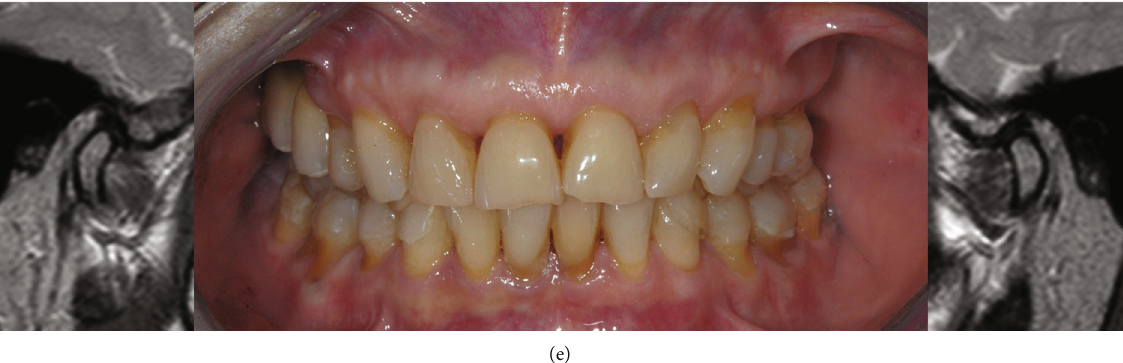
Figure 1: Clinical work fl ow for an occlusal vertical dimension increase in a patient showing worn dentition. ((a) and (b)) Pre-operative intra-oral occlusal photographs showing signs of cervical abrasion/erosion, slight misalignment in the upper anterior, and mild crowding in the lower-anterior areas: aesthetics appears negatively a ff ected. (c) Panoramic X-ray image showing the pre-operative initial condition. (d) A pre-operative temporomandibular joint (TMJ MRI) scan was taken, with the patient in maximum intercuspation, showing healthy and balanced condyle – disc – fossa relationship both on the left and right side. (e) A second TMJ MRI scan was taken with patient dressing resin posterior fi xed splints in order to check the TMJ status in the new mandibular